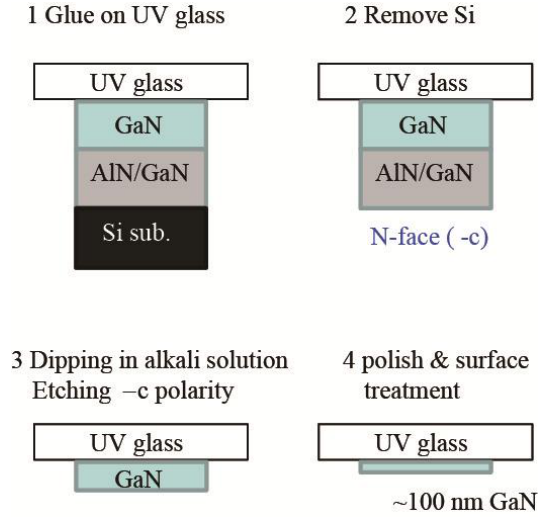
Figure 9. Fabrication process of transparent photocathode based on GaN film grown on Si